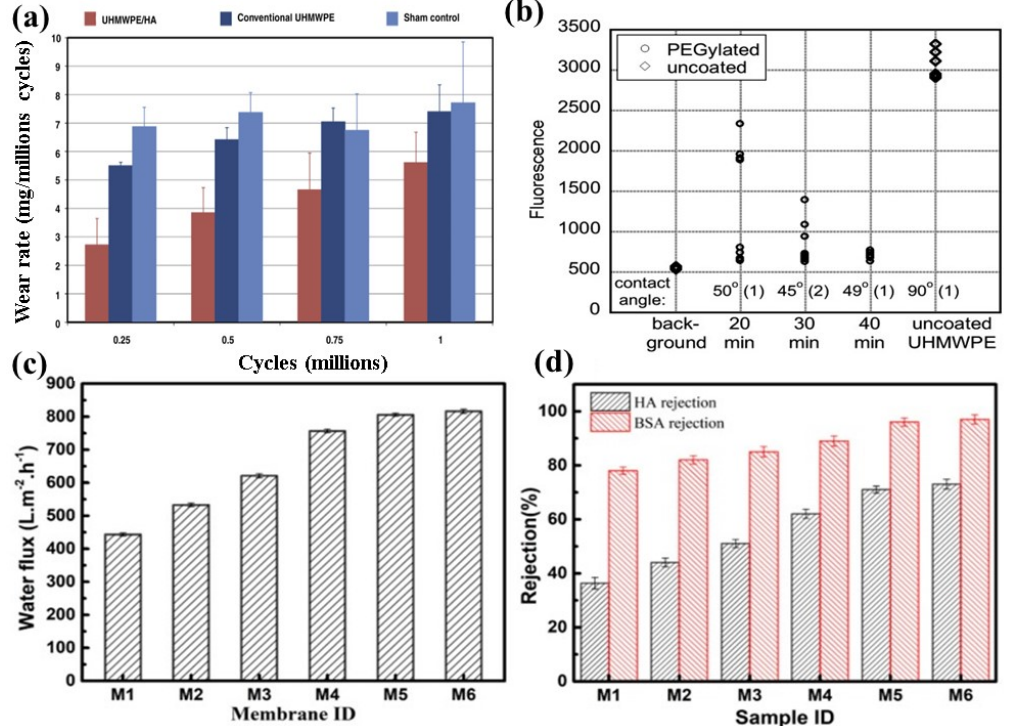
Figure 5. ( a ) Wear rate comparison of conventional UHMWPE and UHMWPE-HA composite and control samples; ( b ) water contact angle and protein adsorption resistance results of untreated and treated UHMWPE; water flux and protein rejection of various membranes; ( c ) Water flux; and ( d ) HA and BSA rejection. Reprinted with permission from [44,45,73].